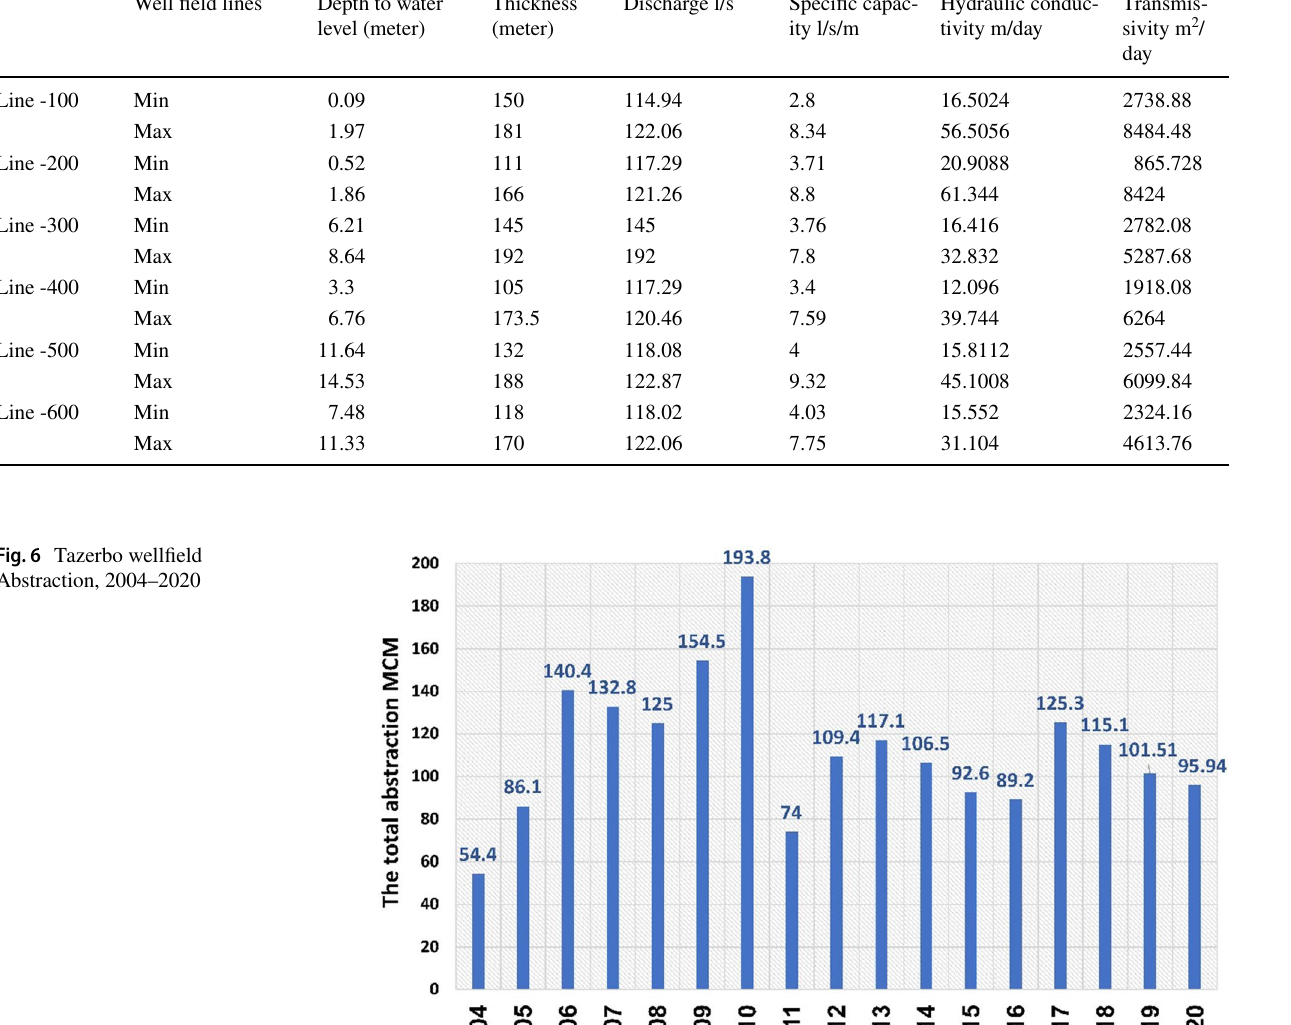
Table 3 Hydraulic properties of the deep aquifer (GMMP and LAVALIN 1999) Well field lines